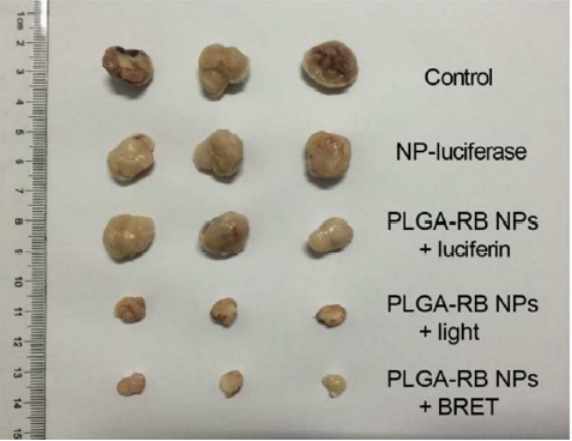
Figure 30. Preparation of PLGA-RB NPs for BRET-PDT. Adapted from Yang et al. [73].